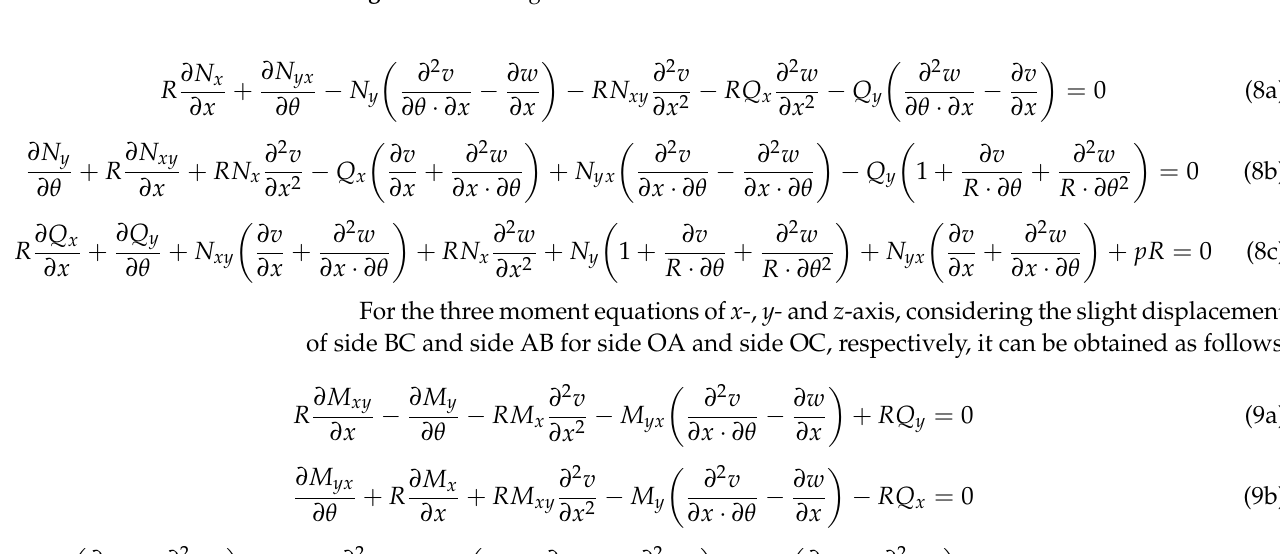
Figure 14. An integral element OABC from the thin shell.